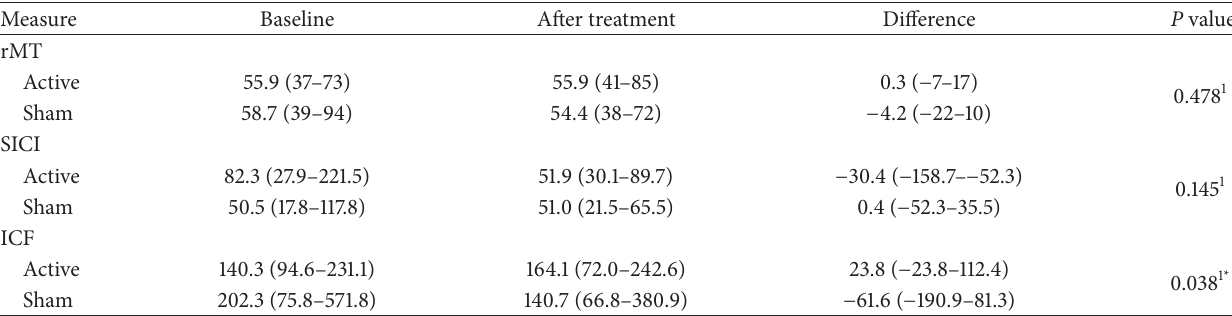
Table 2: Measurements of excitability to transcranial magnetic